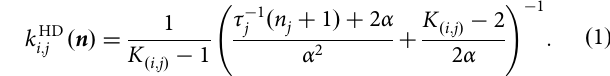
Fig. 2 A combination of crowding and geometry can impede population level transport. a Diagrammatic representation of the microscopic rules within the narrow channel. The red arrows represent moves that are prohibited due to crowding, the green arrows represent permitted jumps. The parameter γ i represents the rate at which particles attempt to exit the right-most reservoir. b Equilibration time of the FMM with individual crowding (solid curve) and without (dot-dashed curve) for a three-reservoir network (inset). The equilibration time of the Ornstein – Uhlenbeck process in both the low- and high- density regimes (dashed black curves). The low- and high-density regimes are highlighted in grey. The parameters are K (1,2) = K (2,3) = 2, τ ¼ δ 2 ; 4 = 3 ; 1 such that 〈 τ 〉 = 13 δ /9 and 〈 τ 〉 varies from 10 − 3 to 10 5 , α = 1, and N = 25. c Diagrammatic representation of the full Markov model (FMM) where narrow channels between reservoirs (large circles) are discretised as integer lattices along which individuals (black dots) undergo crowded transport. d Diagrammatic representation of the reduced Markov model (RMM) where individuals hop directly between adjacent reservoirs. The possible hopping directions are indicated by the